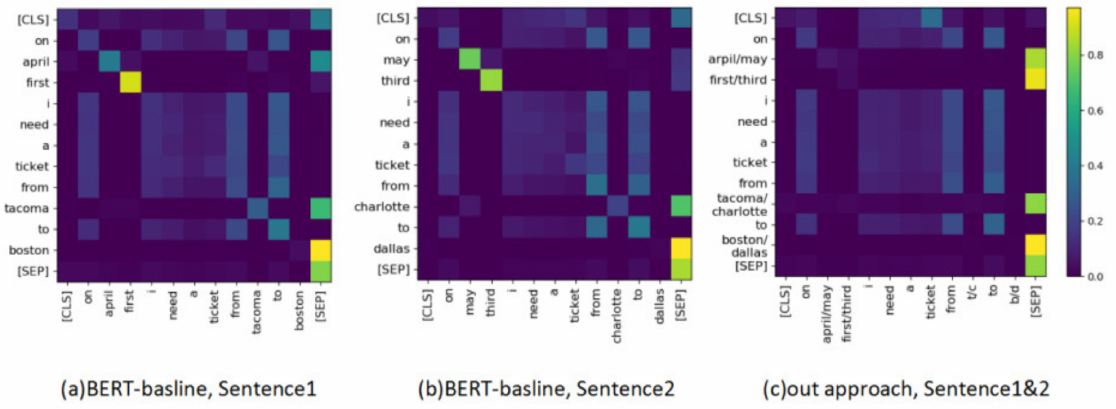
Figure 3. Heat maps comparison of our approach and the BERT-baseline method. It can be seen that our method selects more accurate features in the intent-detection task.